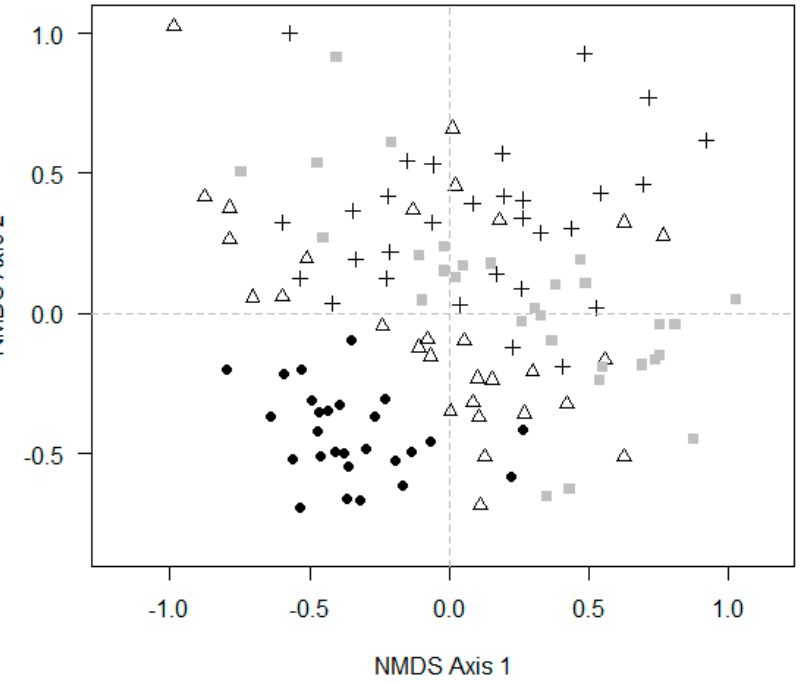
Figure 4. Non-metric multidimensional scaling (NMDS) ordination plot for the samples (quadrats) for Control ( ● ), South ( Δ ), Center (+), and North ( ).